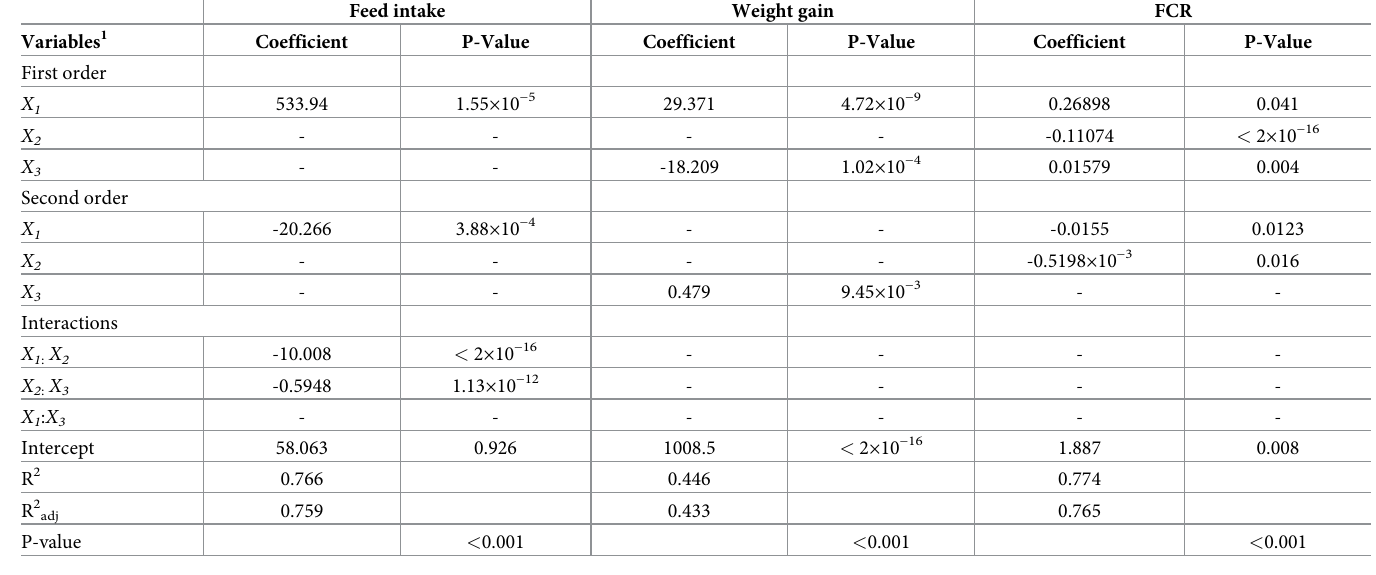
Table 6. ANOVA, coefficient estimates and summary statistics of growth performance in response to digestible lysine concentration (SID Lys), energy density (AMEn) and starch to lipid ratios (S:L) in broiler chickens from 21–35 days